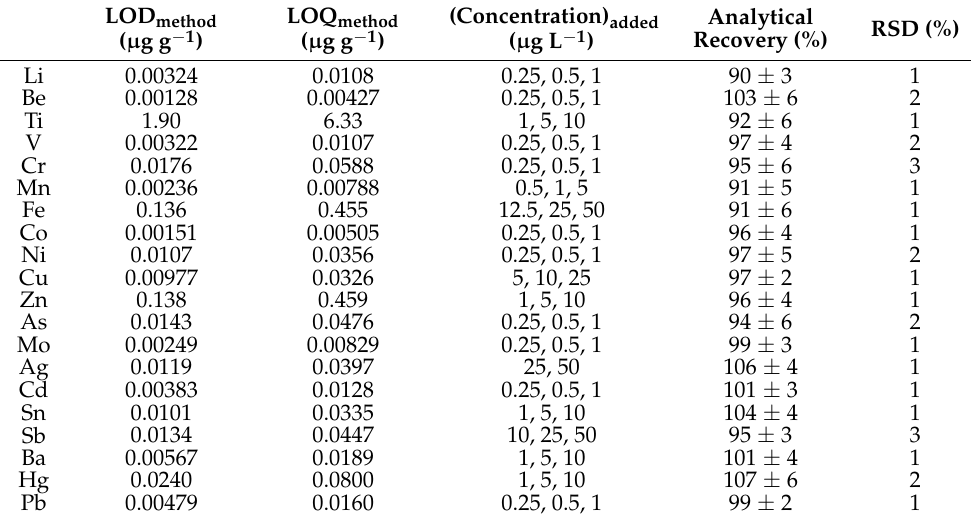
Table 4. Methodology